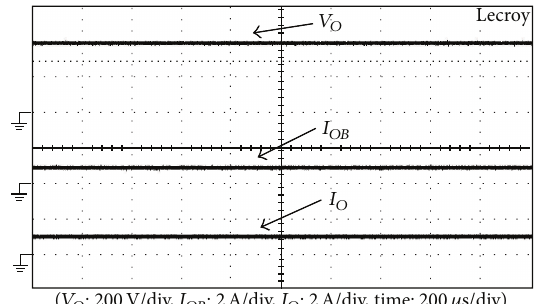
Figure 15: Measured voltage 𝑉 𝑂 , current 𝐼 𝑂𝐵 , and 𝐼 𝑂 waveforms of the proposed PV power conversion system using the single-capaci- tor snubber operated in mode IV under 𝑃 𝐿 = 350 W.